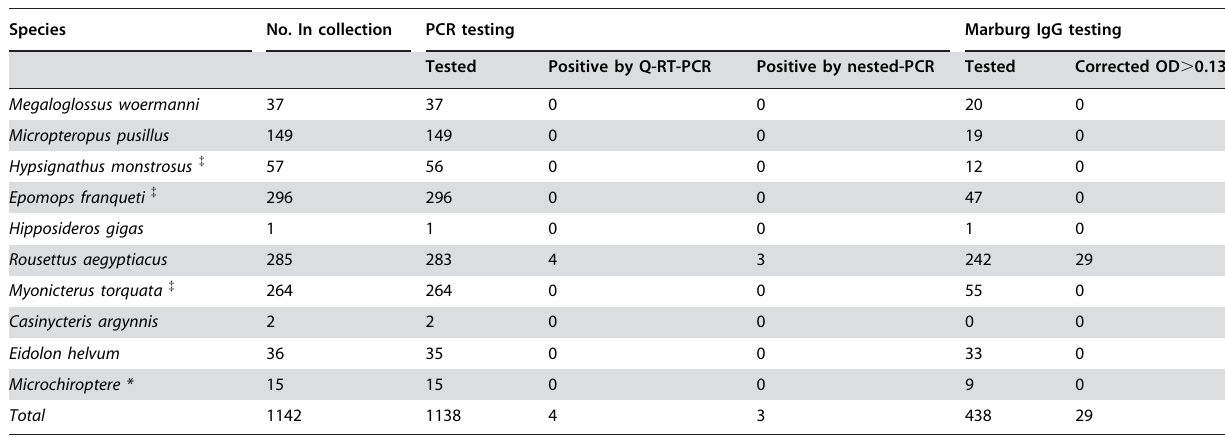
Description of bat species and their respective numbers analyzed by either PCR or serology followed by the number of bats of each respective species that tested positive by real-time RT-PCR, nested RT-PCR or had corrected OD values greater than 0.13 at serum dilutions of 1:100. (*) denotes unspeciated bats of the suborder Microchiroptera. ( { ) denotes bat species previously identified to show evidence of Ebola infection [4].